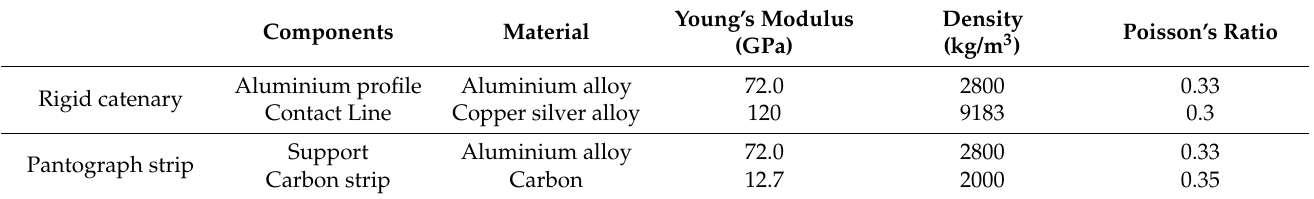
Table 4. Parameter input of the rigid catenary and the pantograph strip.